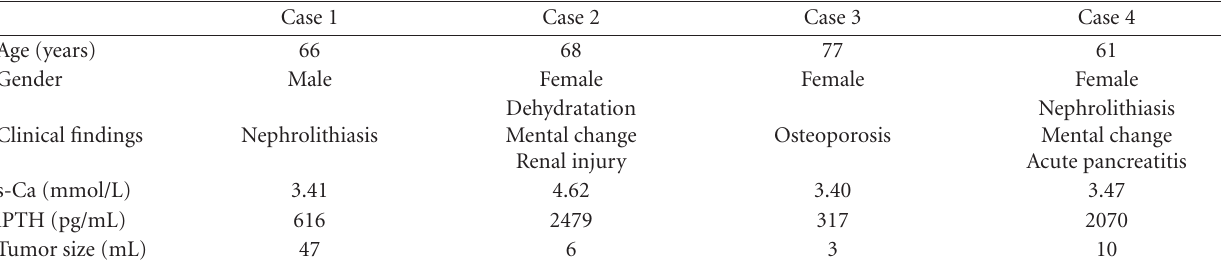
Table 1: Laboratory and clinical findings.